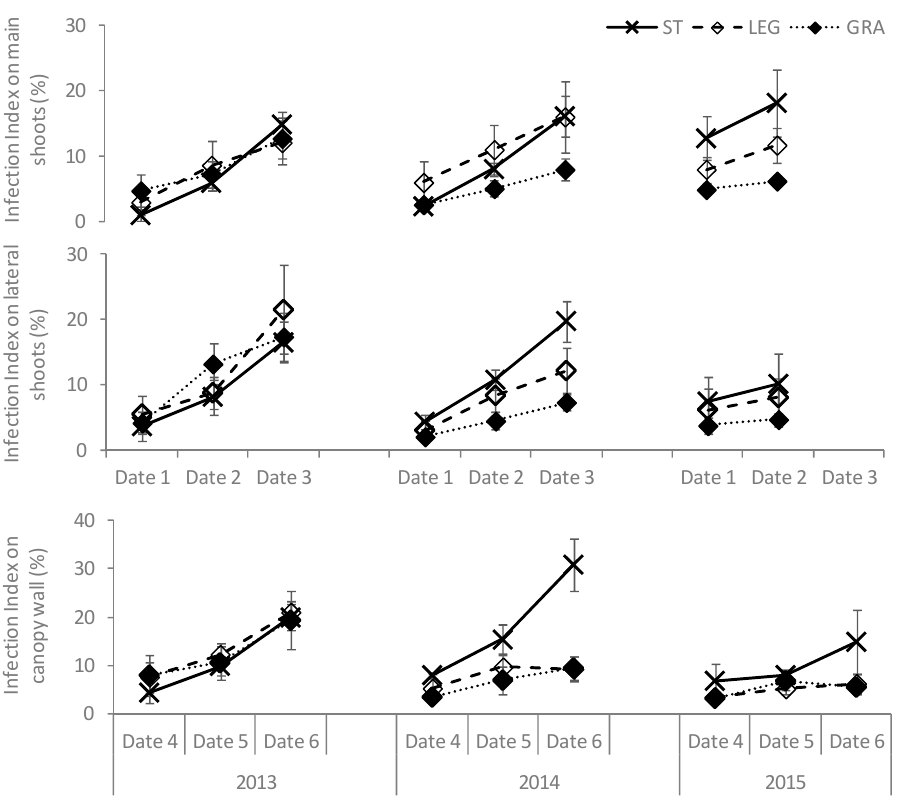
Figure 3. Development of the powdery mildew infection index detected on the main shoot leaves, on lateral shoots, and on the canopy wall, in the three soil management treatments. Values are the mean ± standard error.